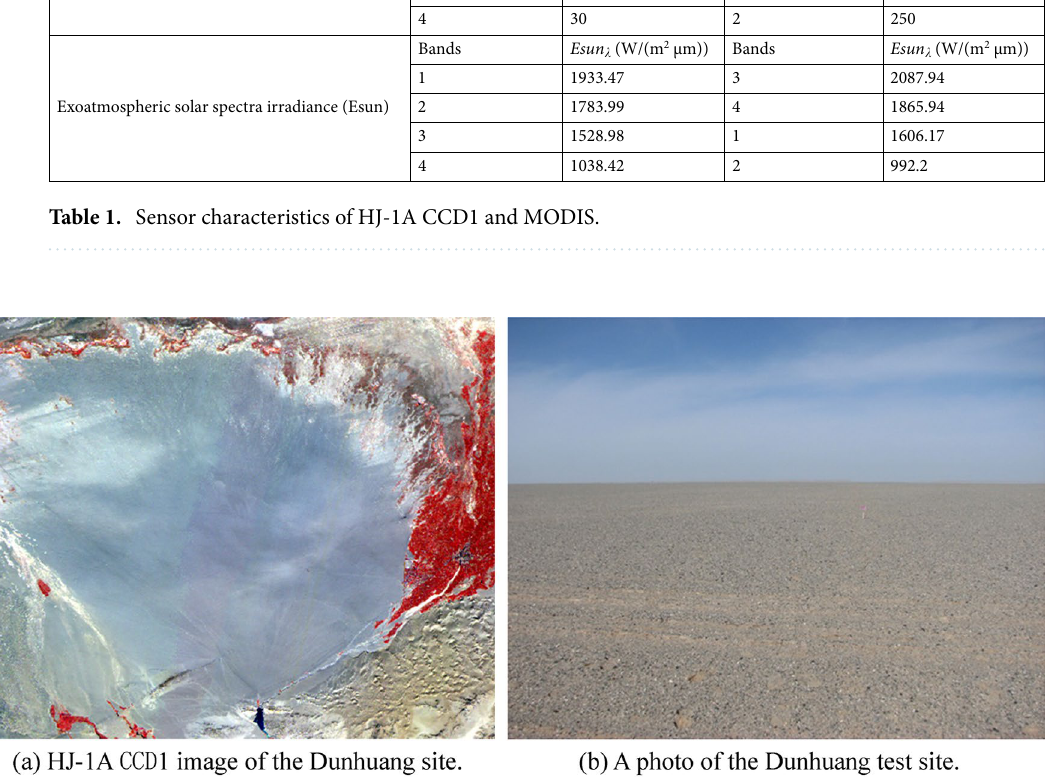
Figure 2. The Dunhuang radiometric calibration